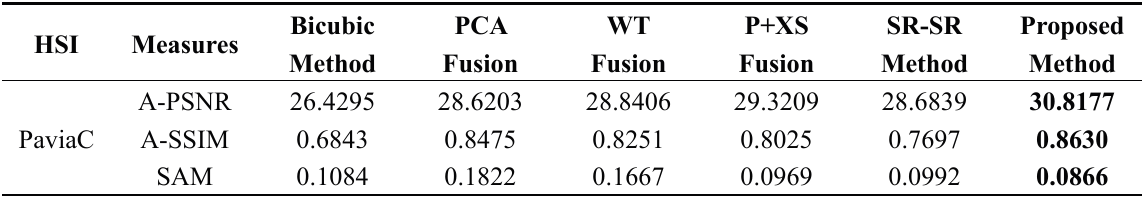
Table 2. Comparison results of A-PSNR, A-SSIM and SAM of the different methods.